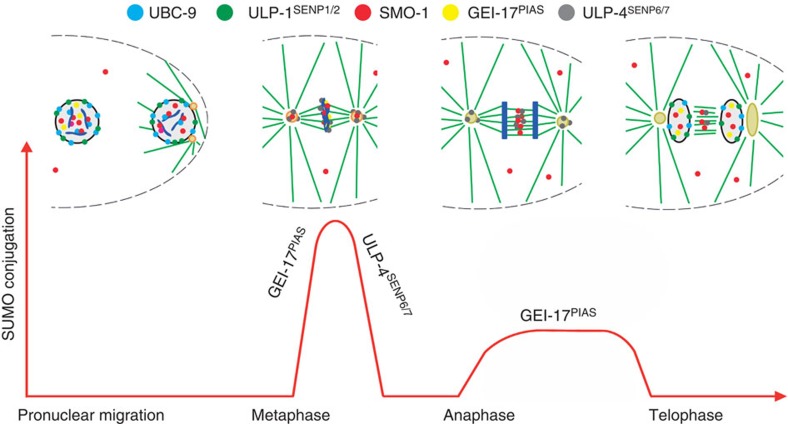
Model.Schematic summarizing the localization of the studied sumoylation pathway components highlighting the dynamic behaviour of SUMO conjugation and the contribution of the SUMO E3 ligase GEI-17PIAS and the SUMO protease ULP-4SENP6/7.